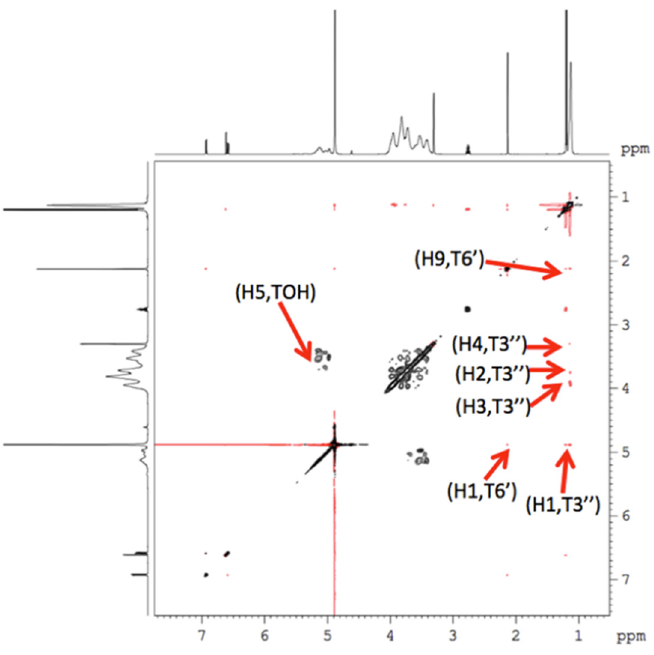
Figure 7. ROESY spectrum of the carvacrol-HP- β -CD complex in methanol-d 4 .